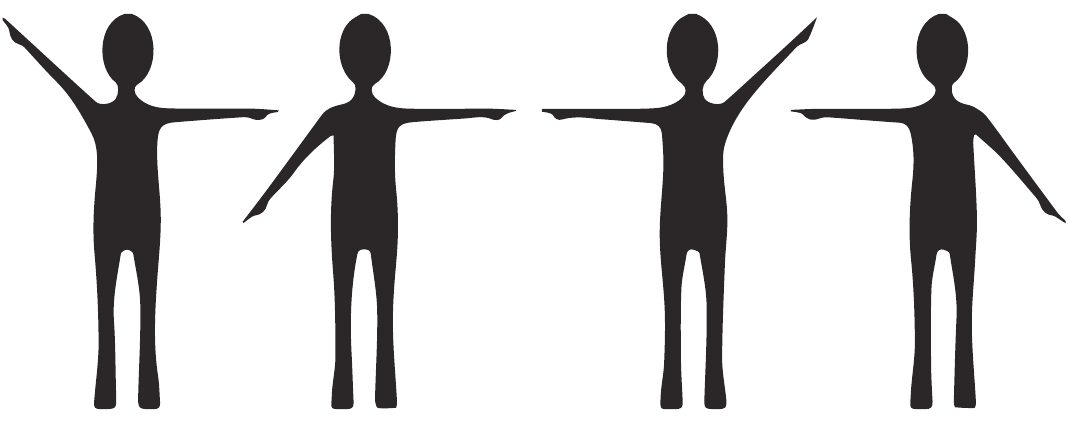
Figure 7: The gestures.